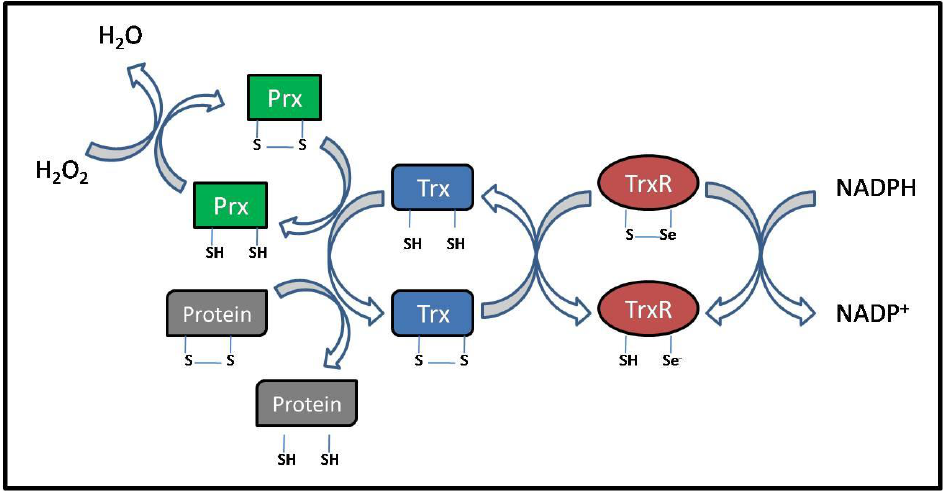
Figure 2. Mechanism of action of the thioredoxin (Trx) redox system. Reduced Trx catalyzes the reduction of disulfides (s-s) within oxidized cellular proteins, such as peroxiredoxin (Prx). In this process Trx becomes oxidized which in return is reduced by thioredoxin reductase (TrxR) at the expense of